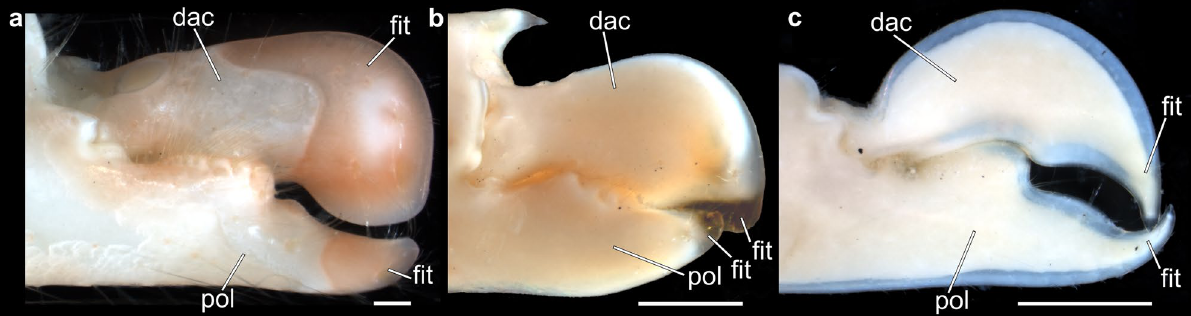
Figure 5. Comparative morphology of snapping claws among selected decapod taxa. ( a ) Alpheidae: Alpheus armatus , preserved specimen (NHMW-CR-19580). ( b ) Alpheidae: Synalpheus gambarelloides , preserved specimen (NHMW-CR-962). ( c ) Palaemonidae: Coralliocaris graminea , preserved specimen (NHMW-CR-7760). Scale bars equal 500 µ m. dac = dactylus, fit = fingertip, pol =